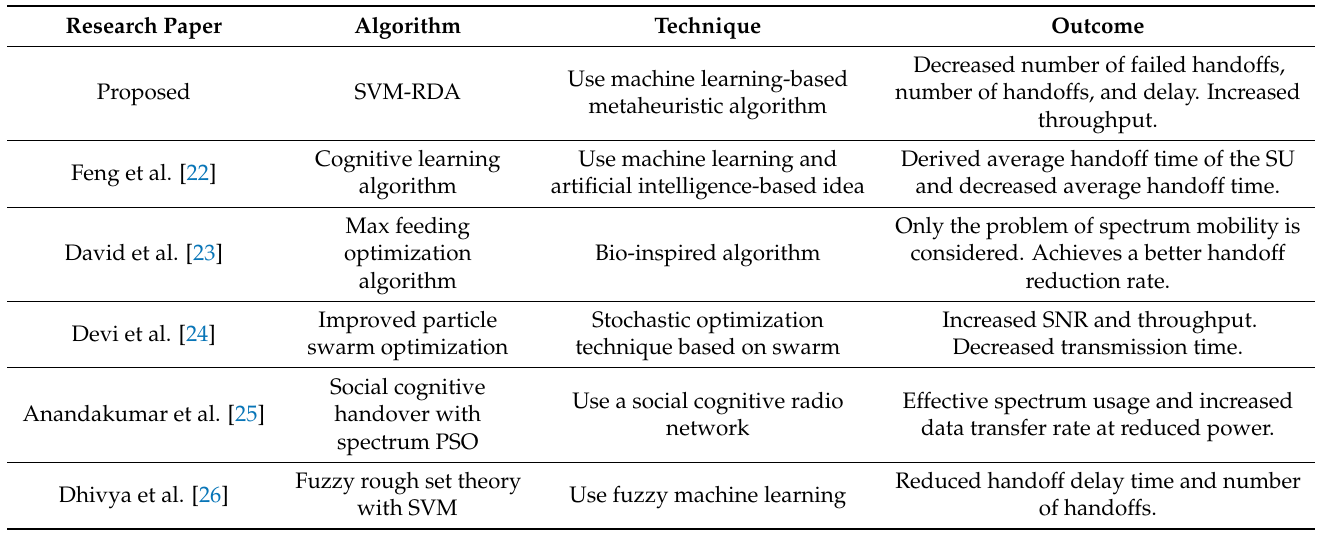
Table 1. Comparison of proposed model with state of the